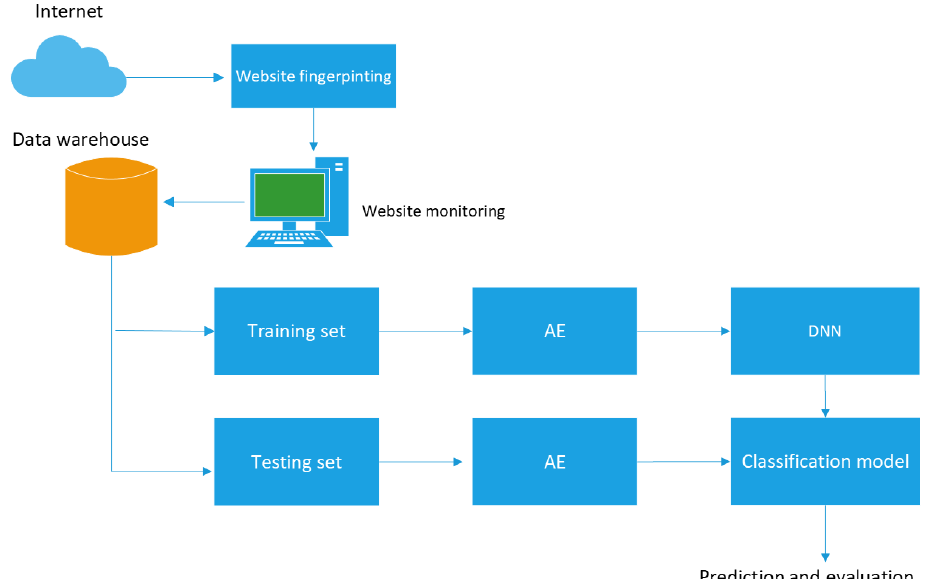
Figure 2. Workflow of the proposed